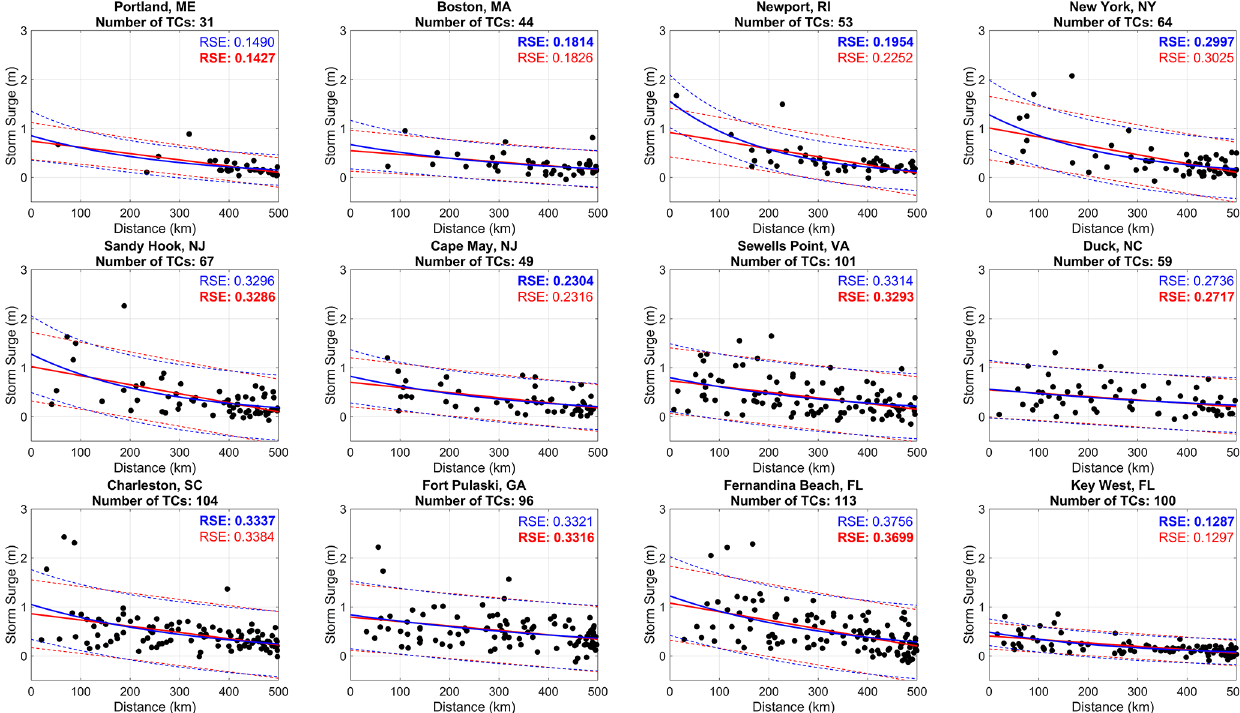
Figure 2. Linear (red solid line) and exponential (blue solid line) fit between storm surge (m) and TC proximity (km) with 95% confidence intervals (dashed lines) for all TCs within 500km. Residual standard error (RSE) is provided for each type of fit with the lower value bolded.